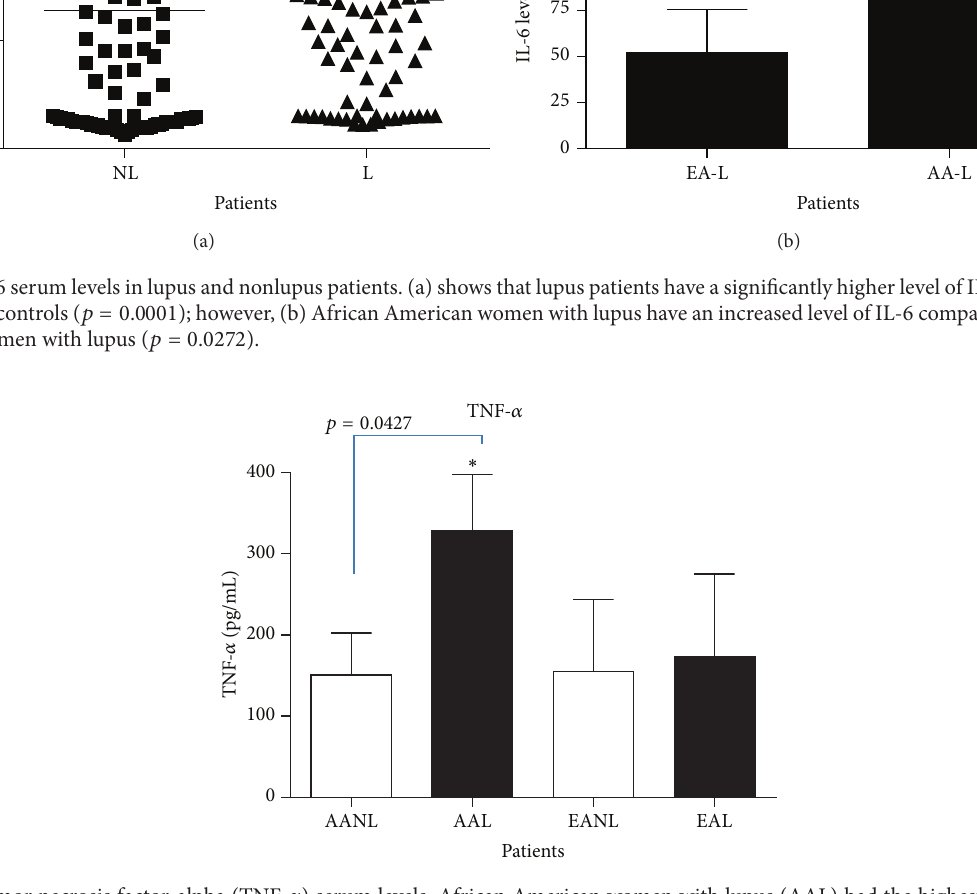
Figure 8: Tumor necrosis factor-alpha (TNF- 𝛼 ) serum levels. African American women with lupus (AAL) had the highest level of TNF- 𝛼 compared to European American women with lupus ( 𝑝 = 0.0427